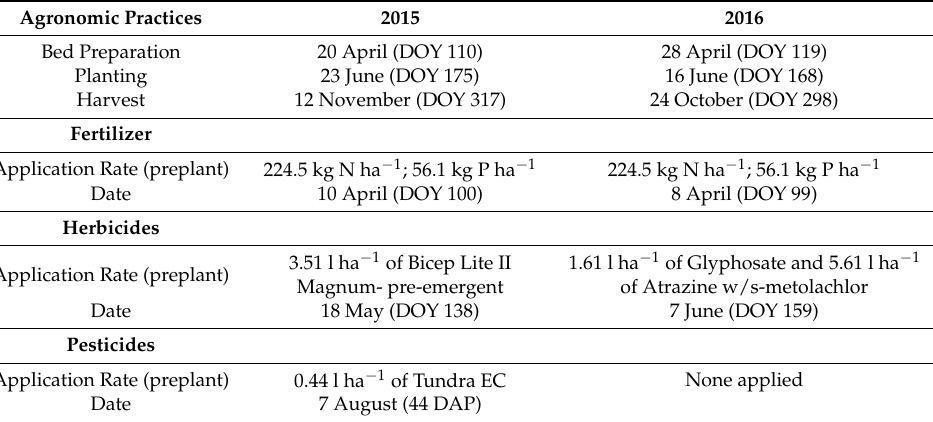
Table 5. Agronomic practices for the 2015 and 2016 growing